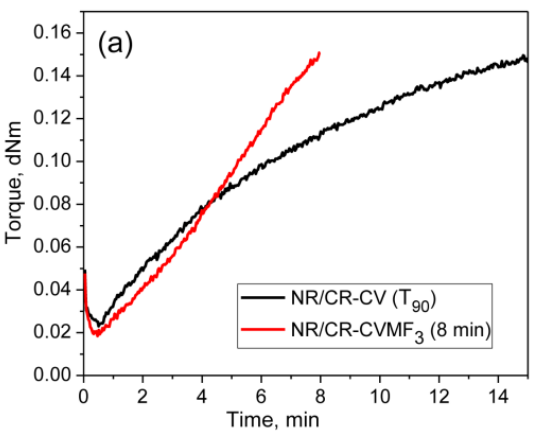
Figure 5. Plausible mechanism proposed for the compatibilisation (co-curing) effect of MF between NR and CR (BIIR) via Diels–Alder